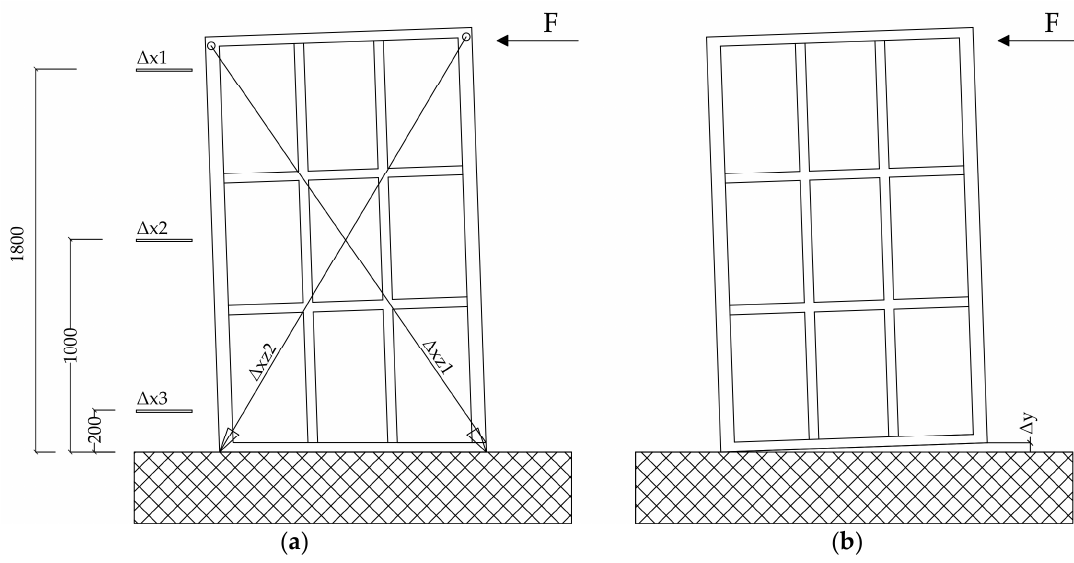
Figure 7. Plan of the instrumentation used (dimensions in mm). ( a ) In-plane deformation; ( b ) rotation (rocking movement).